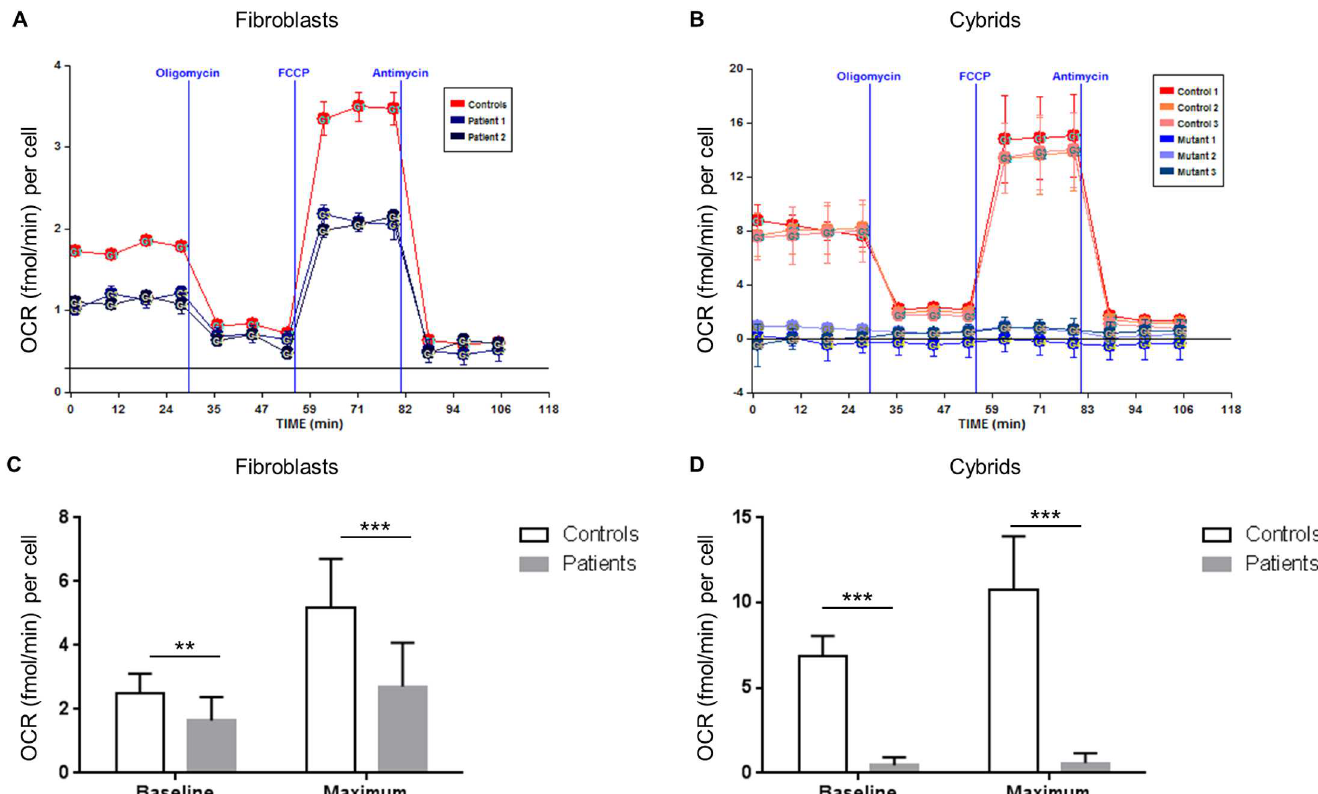
Fig 2. Mitochondrial function is impaired in m.547A > Tfibroblasts and cybrids. Oxygen consumption rate (OCR) was measured to assess mitochondrial function in fibroblasts(A, C) and cybrids (B, D), normalised for cell number. Representative comparisonof fibroblasts(A) and cybrids (B) from control individuals (red) with fibroblasts or cybrids from patients with the m.547A > T substitution (blue) showinga substantialchangein respiratory profile. There was a significantdecrease in baselineoxygen consumption,and in maximal oxygen consumption followingadditionof FCCP in both fibroblasts (C) and cybrids (D). Asterisks * p < 0.05, ** p < 0.005, and *** p < 0.001 for control versus patient groups, representedas the mean ± SD of separateexperiments performed in triplicate with four patient and four control cell